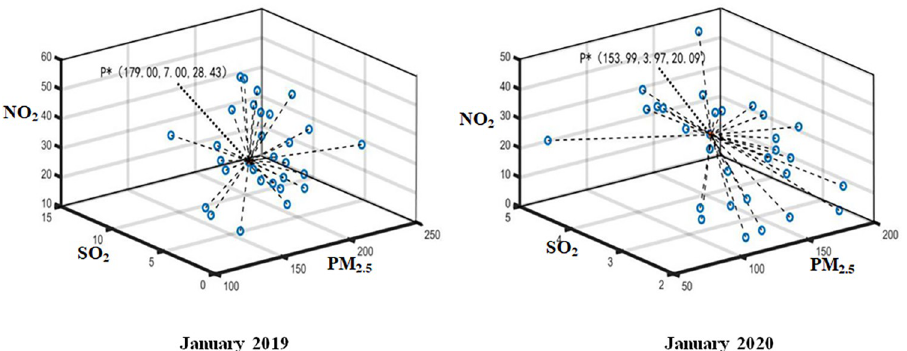
Fig 4. Aggregation result in January 2019 and 2020.